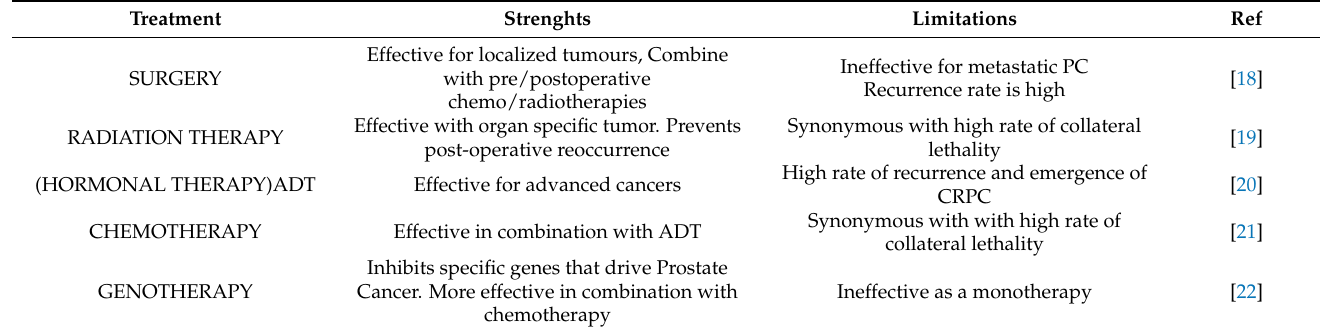
Table 1. Different treatment options for prostate cancer and their pitfalls.